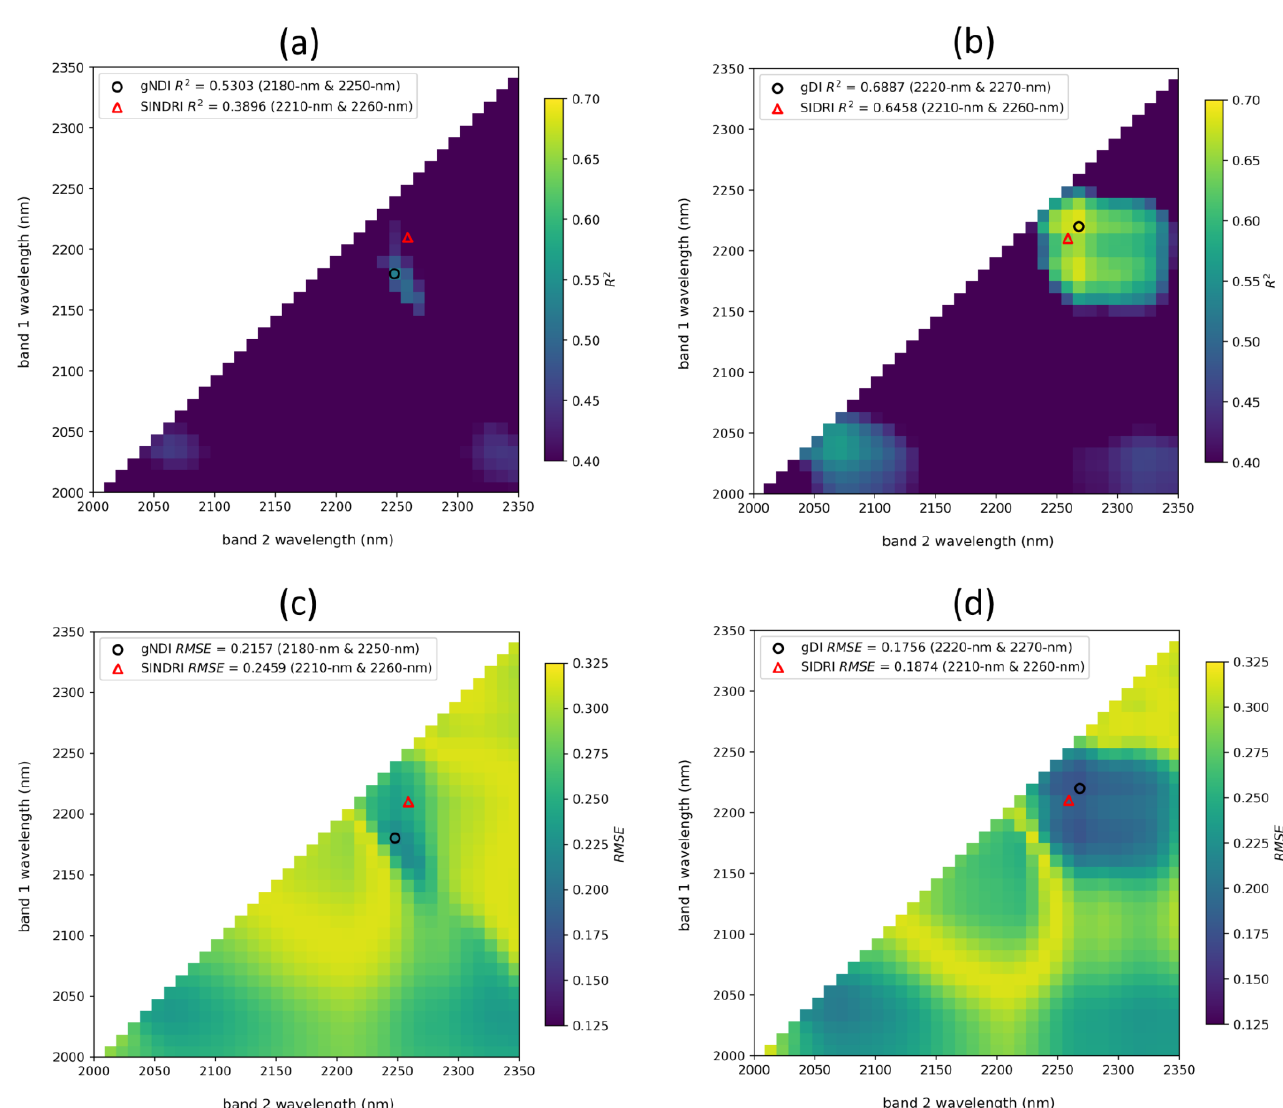
Figure 3. Performance metrics for two-band wavelength shift indices computed from the full-NDVI 10 nm dataset with n = 916: ( a ) gNDI- R 2 , ( b ) gDI- R 2 , ( c ) gNDI- RMSE , ( d ) gDI- RMSE . In all panels, the gray/black circles represent the band combination that produced the best f R estimation performance, as defined by the respective performance metric. The red triangles depict the band combination of a comparable heritage index. Results shown are from SR-processed spectra. The results for atm-processed spectra identified the same top-performing bands as the SR-processed spectra and are shown in Table 1. Supplementary Materials Figures S3 and S4 provide side-by-side comparisons of SR-processed (panels a and c) and atm-spectra (panels b and d) results.